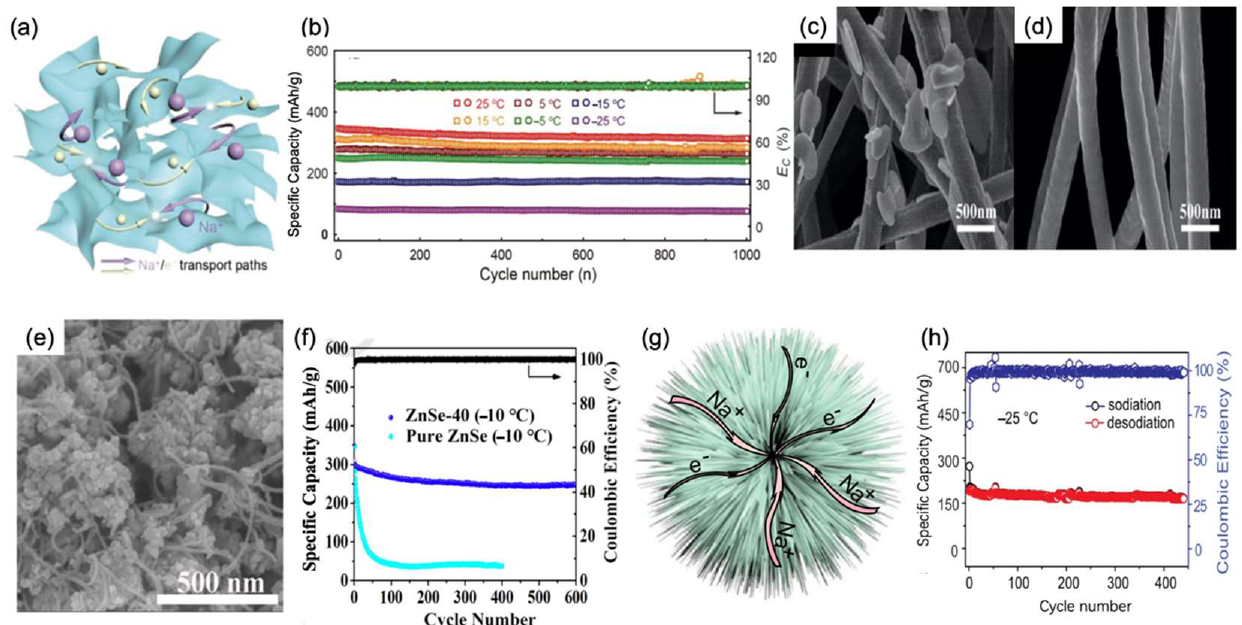
Figure 7. ( a ) Three-dimensional framework of 3DSG, showing the transportation of Na + and e - . ( b ) Long-term cycling in a range of temperatures at a 2 C rate. Reproduced with permission from Ref. [46]. Copyright 2018 WILEY-VCH. ( c , d ) SnSe@CNFs optical image without the addition of Se powder. Reproduced with permission from Ref. [48]. Copyright Springer Nature 2019. ( e ) SEM image of ZnSe-40. ( f ) Long-term cycling performance of ZnSe-40 and pure ZnSe at −10 °C. ( g ) Schematic illustration of Fe 7 Se 8 @C 3D structure with Na + and e − transportation routes. ( h ) Specific capacity and coulombic efficiency of cl-Fe 7 Se 8 @C//NVPOF full cell after 400 cycles at −25 °C. Reproduced with permission from Ref. [50]. Copyright 2019 American Chemical Society.